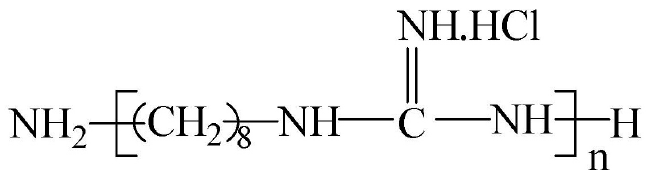
Figure 1. The chemical structure of polyoctamethylene monoguanidine hydrochloride (POGH). 2.2. Strains